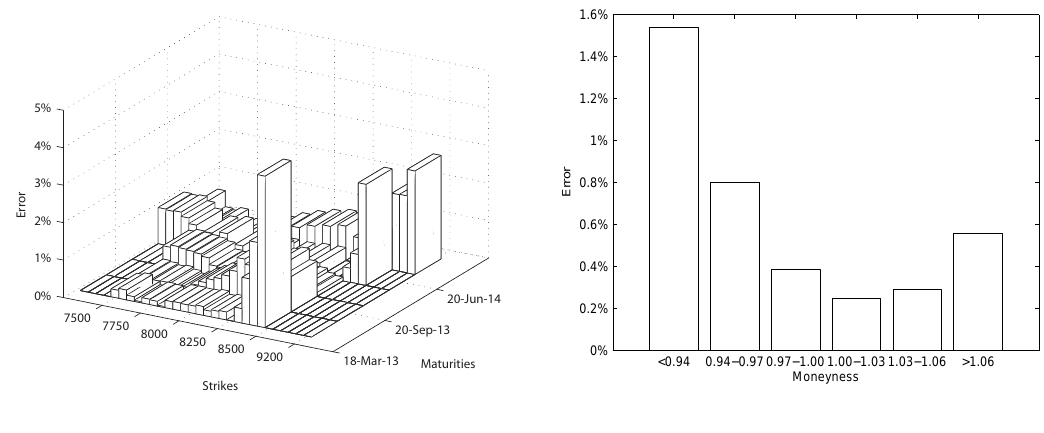
Fig. 3. Results for ASA. The left picture portrays the absolute relative errors. The right picture shows the average absolute relative errors in terms of moneyness.